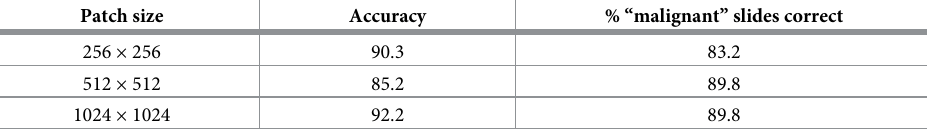
Table 2. Accuracy and percentage of “malignant” slides correctly classified for three different patch